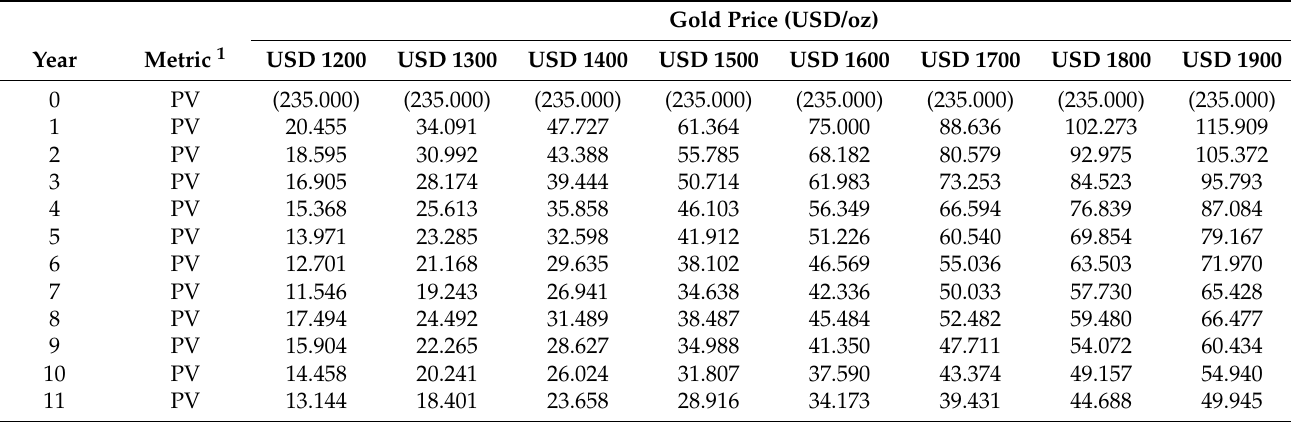
Table 5. Summary of net present value (NPV) calculations for a range of potential gold prices